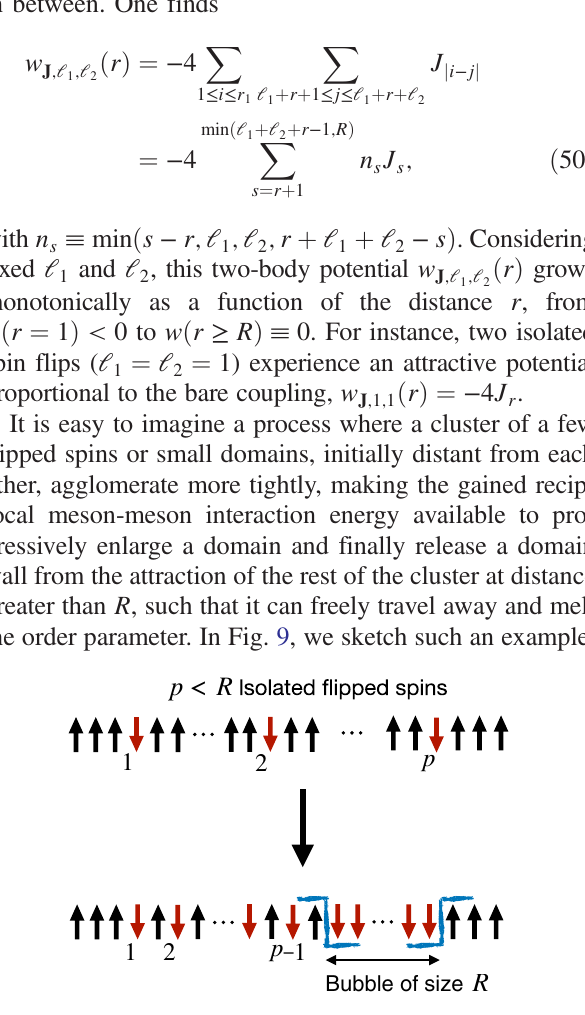
FIG. 9. Quasilocal cluster of a few ( p < R ) spin flips (top configuration), which could agglomerate tightly and convert the accumulated extra interaction energy into the formation of a reversed bubble of size R (bottom configuration), thus releasing a free domain wall while conserving the total number of domain walls. While energetically allowed, such a process can be shown to be necessarily off-resonant under generic incommensurability assumptions on the couplings f J (see main r g